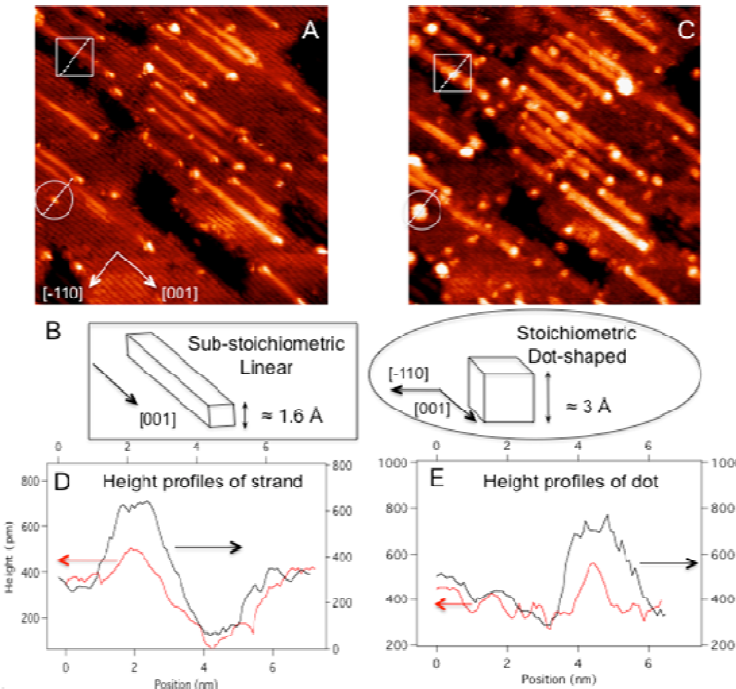
( B ) schematic diagrams of substoichiomeric strand and stoichiometric dot defects contrasting their distinct topographical features; ( C ) STM scan of the same area in ( A ) after 1 min Au deposition at room temperature ( ≈ 0.02 ML). The height profiles, across ( D ) the strand and ( E ) the dot defects ((highlighted in squares and circles, respectively), reveal a marked increase in the height as well as the FWHM along [ − 110] (along the dotted lines) due to Au adsorption. The height profiles before and after Au adsorption are shown in red and black lines, respectively. Both STM scans are taken with V = 1.80 V and I = 0.5 nA for ( A ) and V = 1.42 V and 0.5 nA for ( C